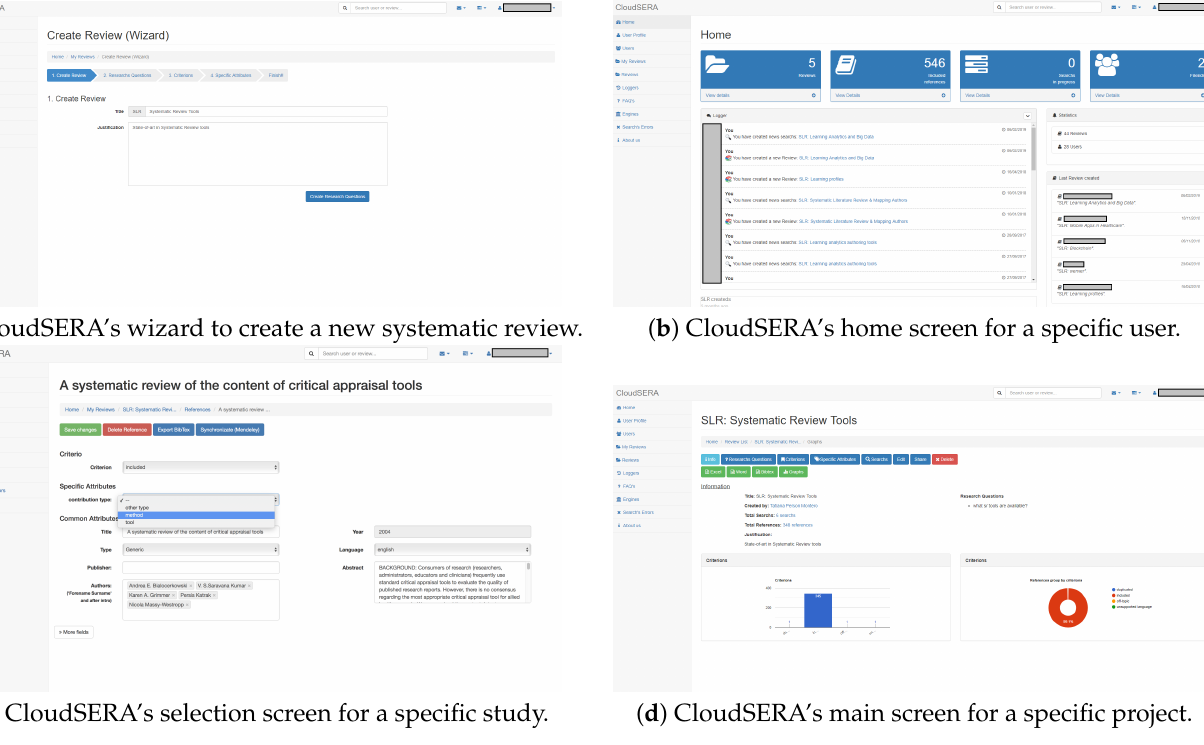
Figure 3. CloudSERA’s main